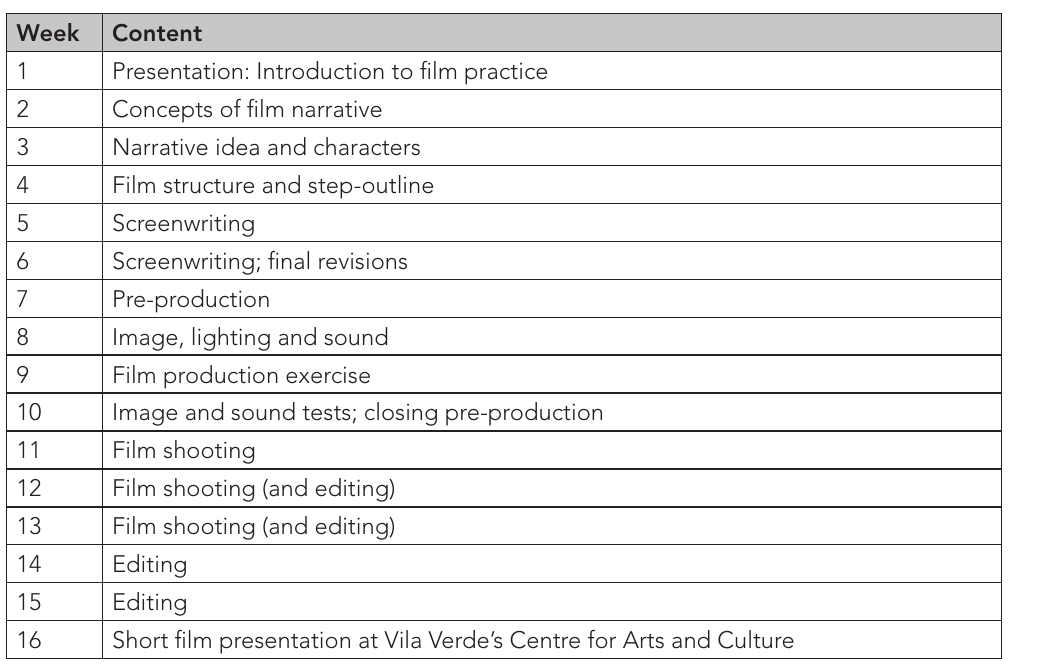
table 1: distribution of contents throughout the 16 weeks of